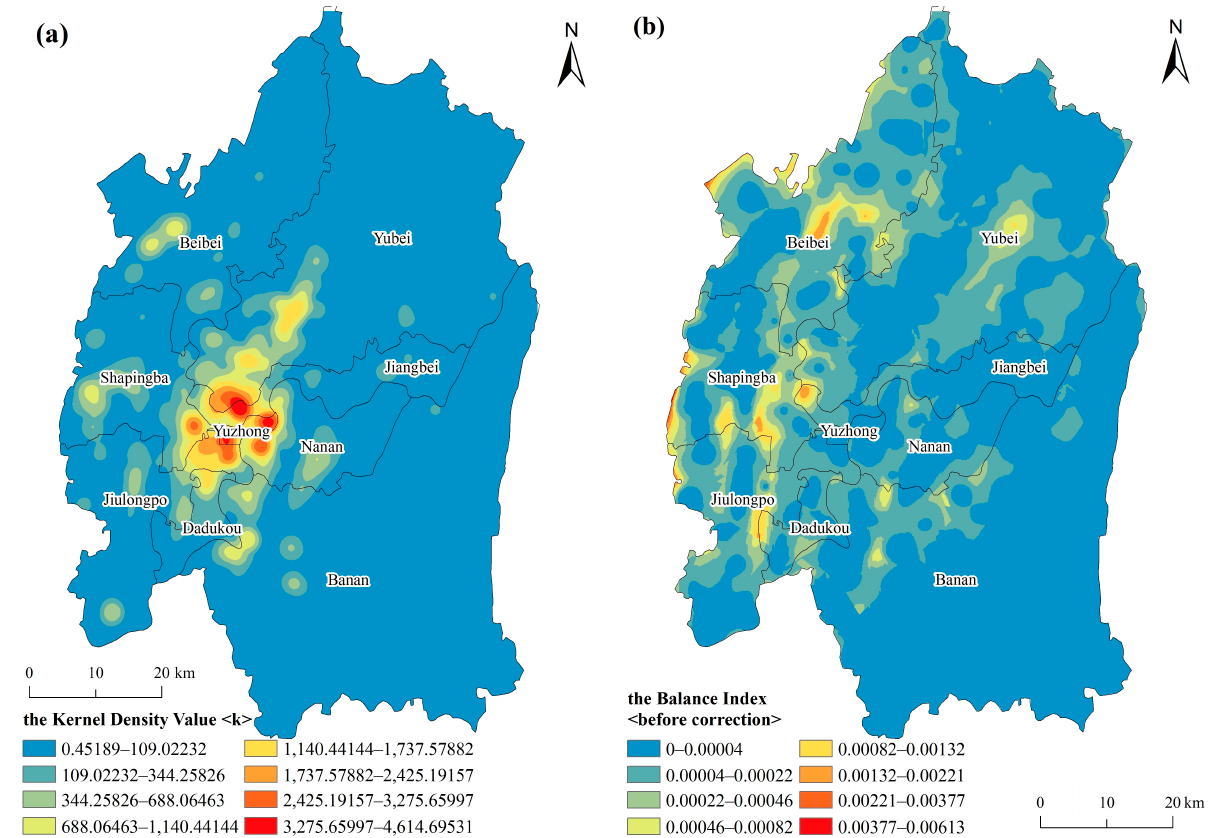
Figure 4. ( a ) Analysis of the nucleus density of points of interest in the central urban area of Chongqing; ( b ) Map of supply and demand of electric vehicle charging infrastructure in the central urban area of Chongqing (before correction).